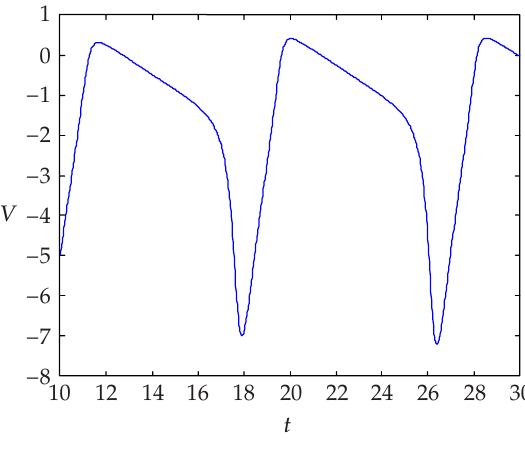
Figure 2.2 . Action potential in the interval t ∈ ( 10 , 30 )